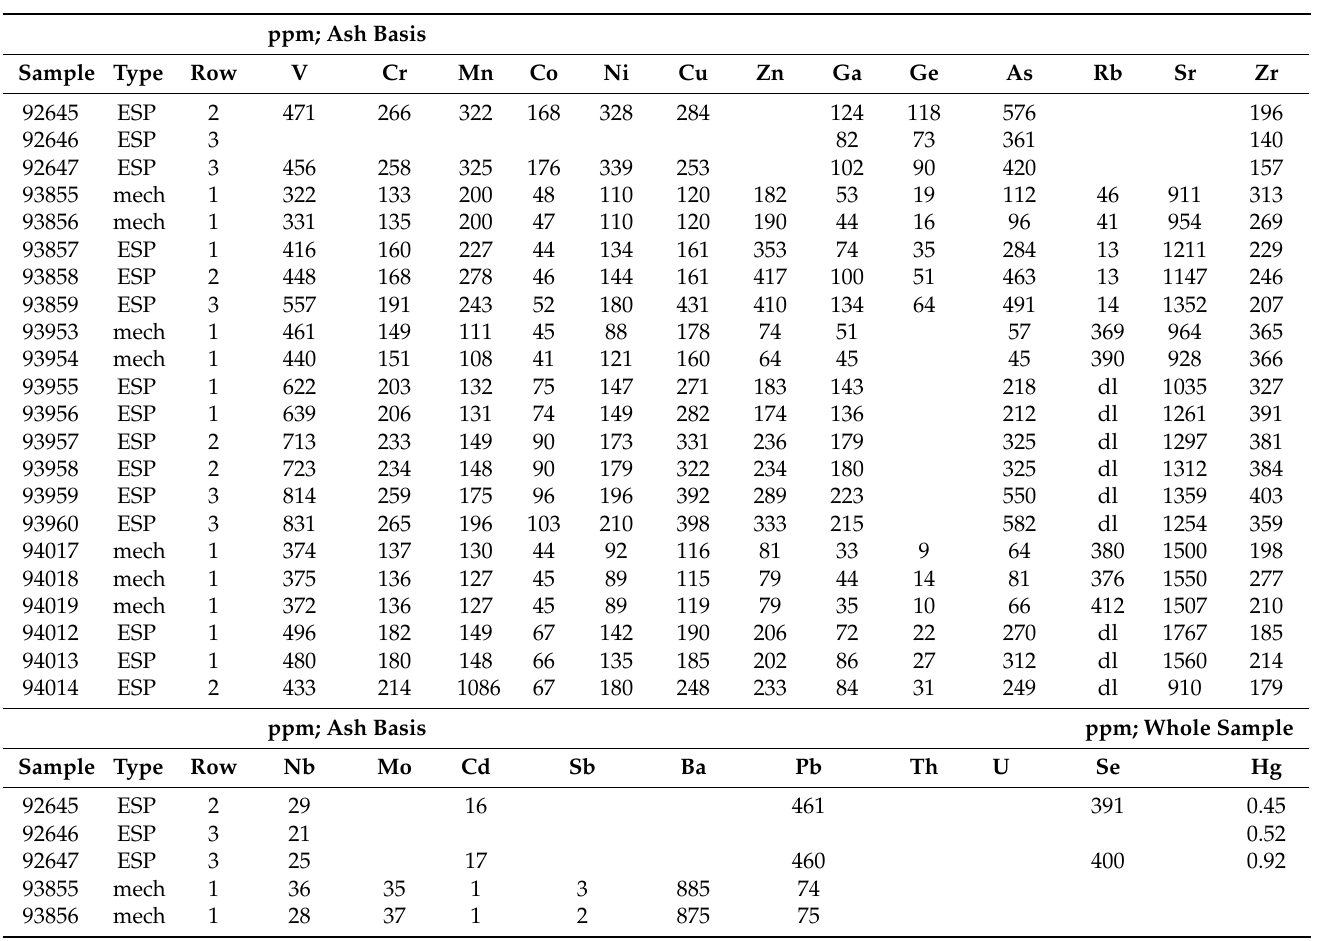
Table 3. Minor elements (ash basis with the exception of Se and Hg on the whole-sample basis). dl—detection